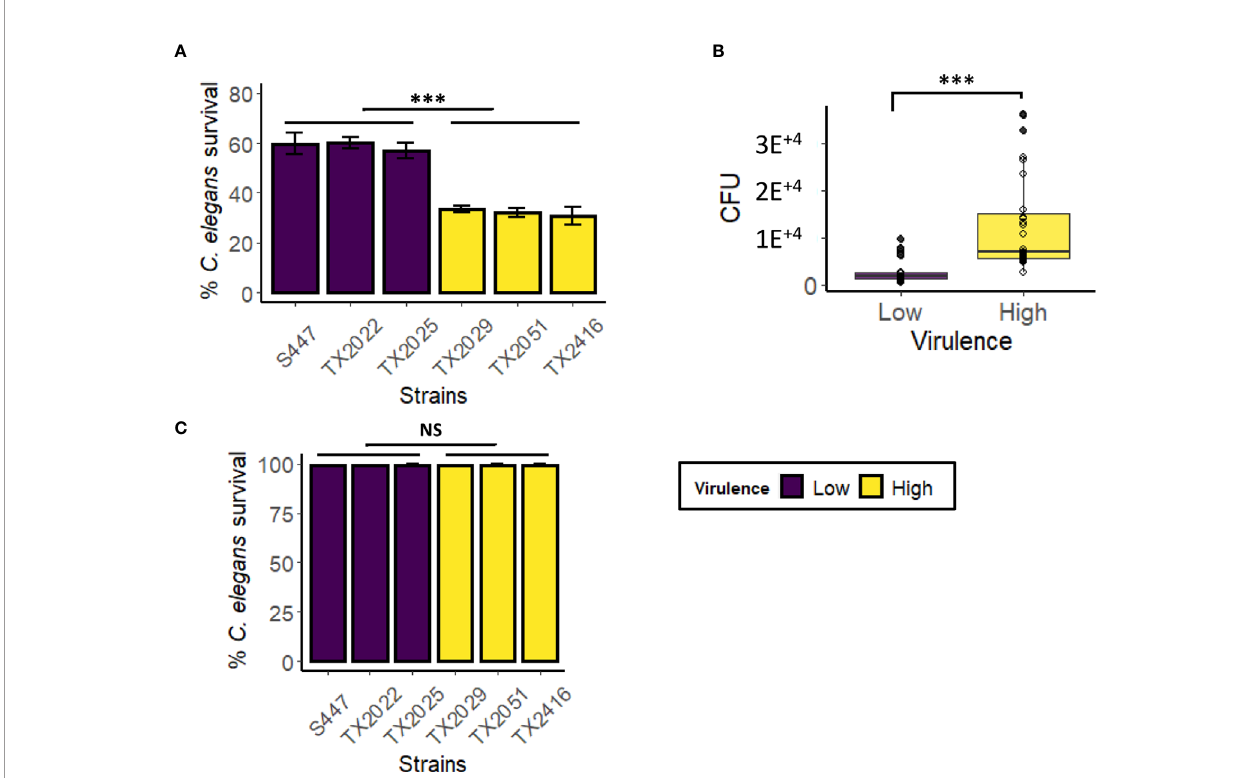
strains ( Figure 6B and Figure S3 , p < 0.001, pooled low- and high- virulence groups). To ensure that only bacteria from the worm